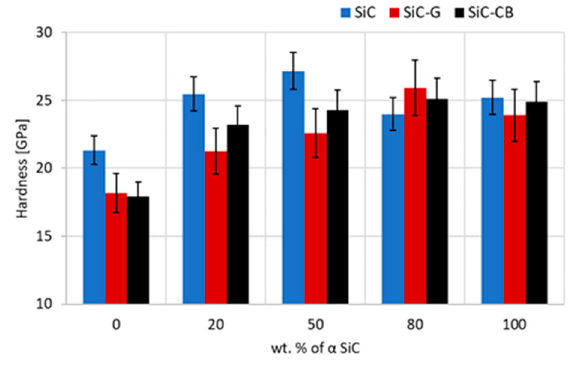
Figure 8. Hardness of the SiC sinters.